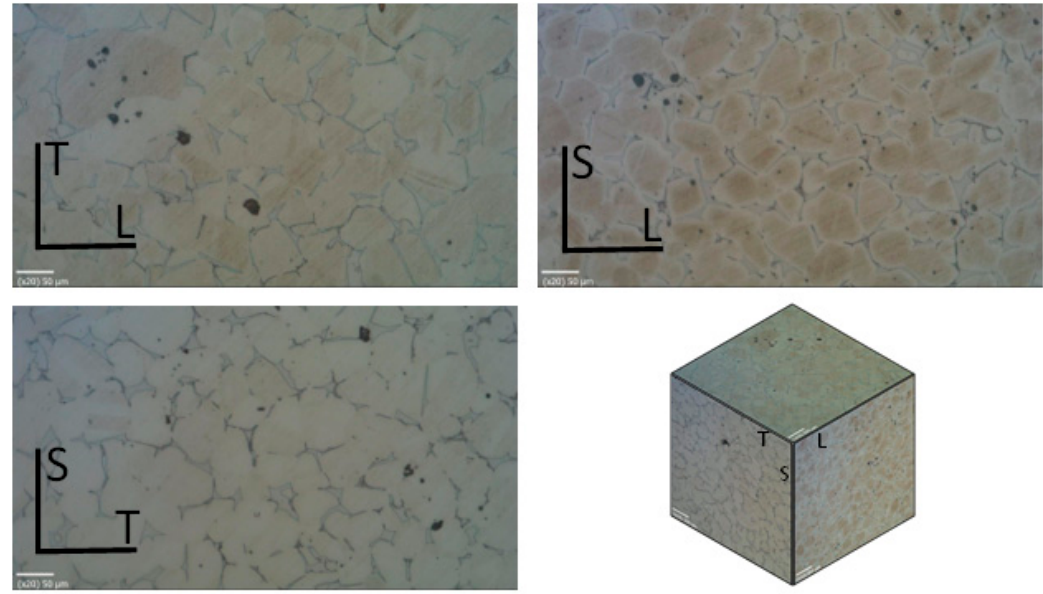
Figure 2. Orientations and microstructure in AISI 316L manufactured using binder jetting.